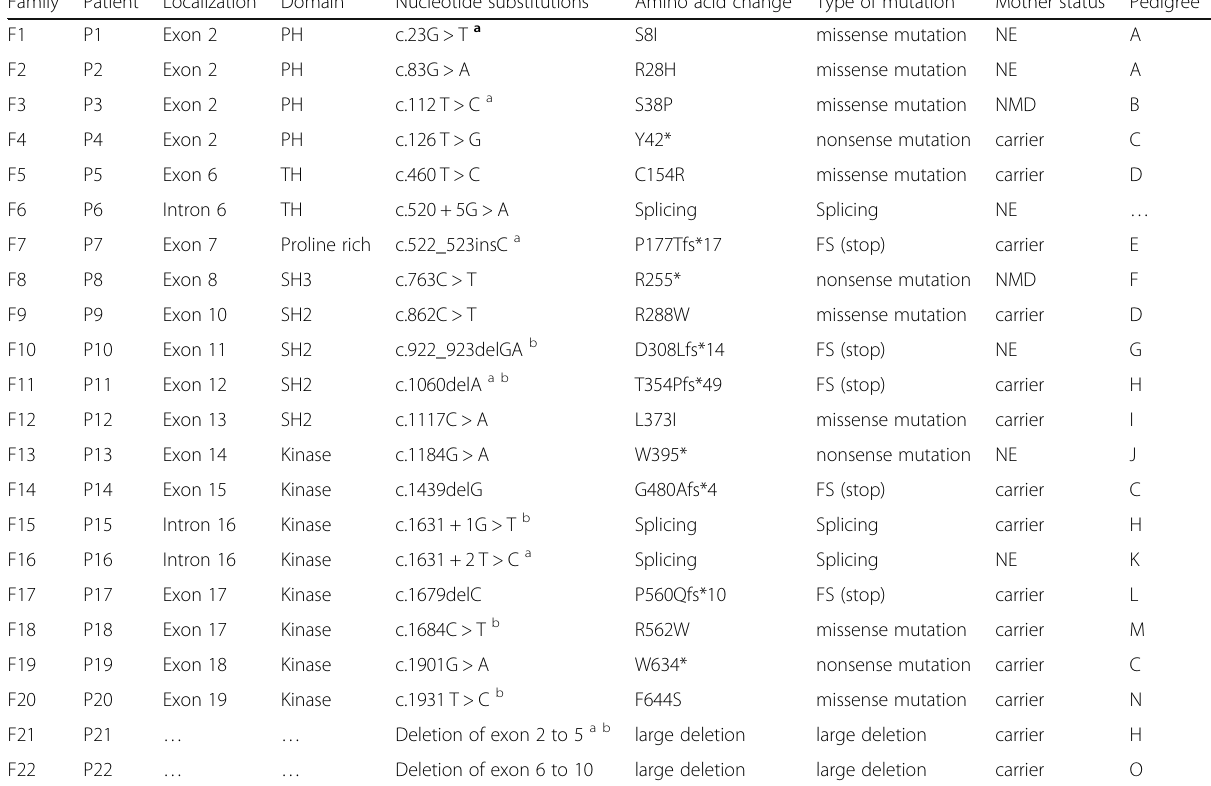
Table 2 BTK gene mutations in 22 XLA patients from 22 unrelated families Family Patient Localization